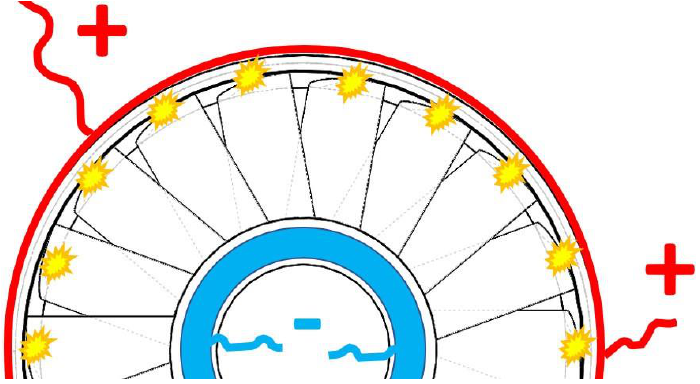
Figure 52. Electrical resistance welding (ERW) concept for production cost savings for the stators (red / blue—electrodes): to be